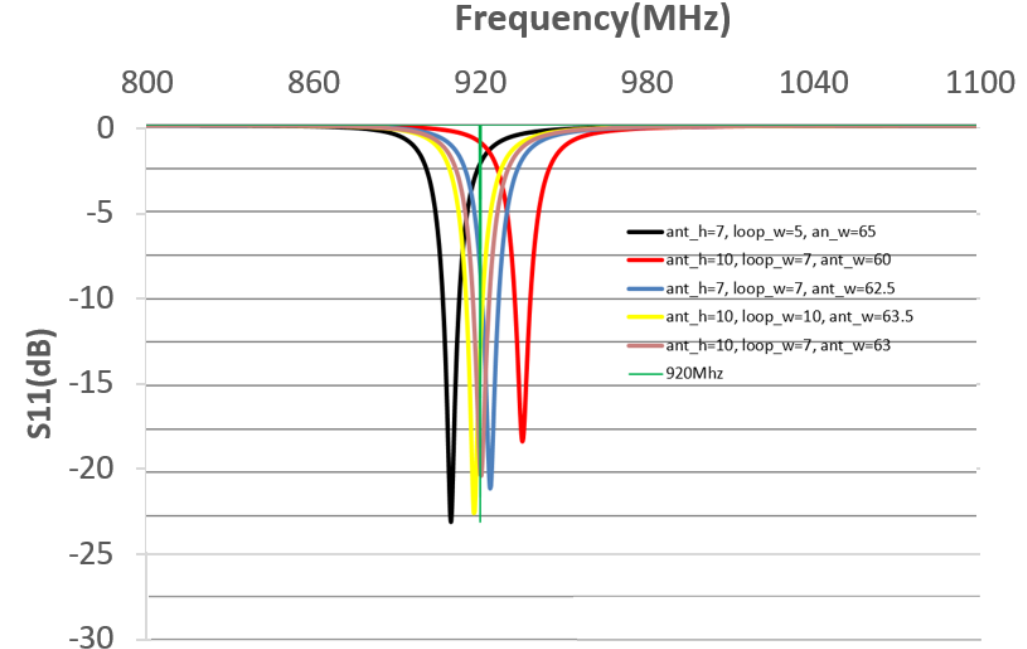
Figure 7. Optimization using parameter sweep S11 (dB) vs. frequency (GHz).